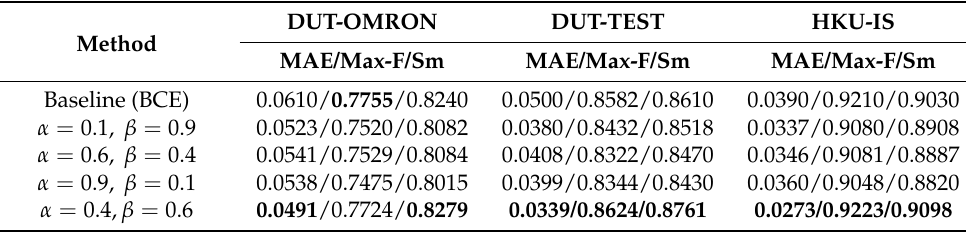
Table 4. Ablation analysis of hybrid loss hyper-parameters. α denotes ration of (BCE+SSIM), β denotes ration of (Dice+IOU). The best results are in bold. DUT-OMRON DUT-TEST HKU-IS Method MAE/Max-F/Sm MAE/Max-F/Sm MAE/Max-F/Sm Baseline (BCE) 0.0610/ 0.7755 /0.8240 0.0500/0.8582/0.8610 0.0390/0.9210/0.9030 α = 0.1, β = 0.9 0.0523/0.7520/0.8082 0.0380/0.8432/0.8518 0.0337/0.9080/0.8908 α = 0.6, β = 0.4 0.0541/0.7529/0.8084 0.0408/0.8322/0.8470 0.0346/0.9081/0.8887 α = 0.9, β = 0.1